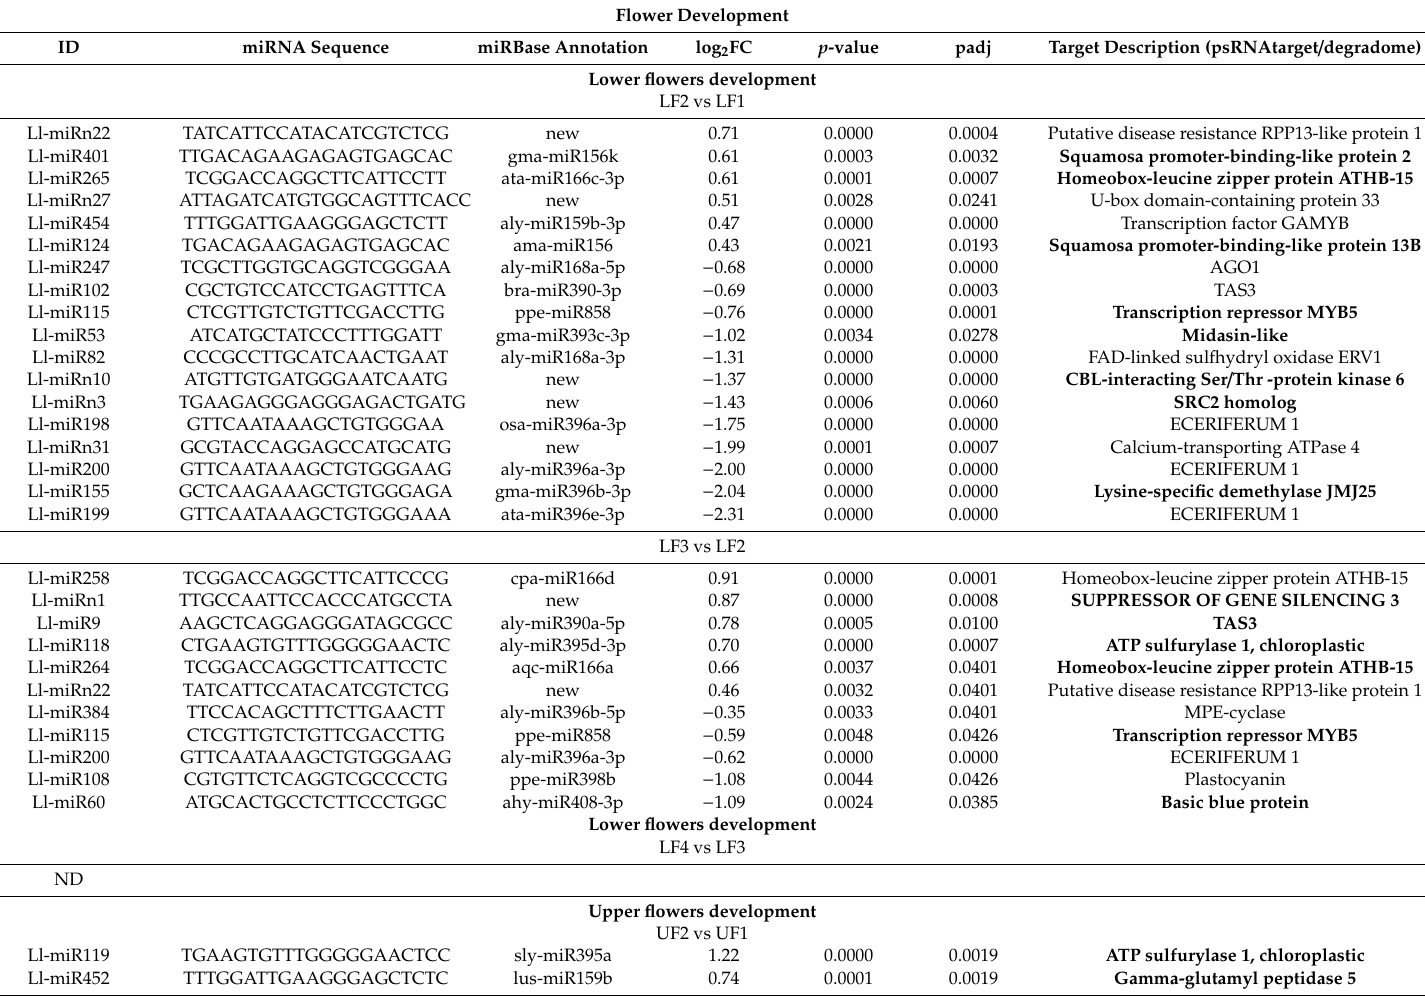
Table 4. Expressed miRNAs identified in comparisons of flower development stages between lower and upper parts of the raceme with padj < 0.05. Flower